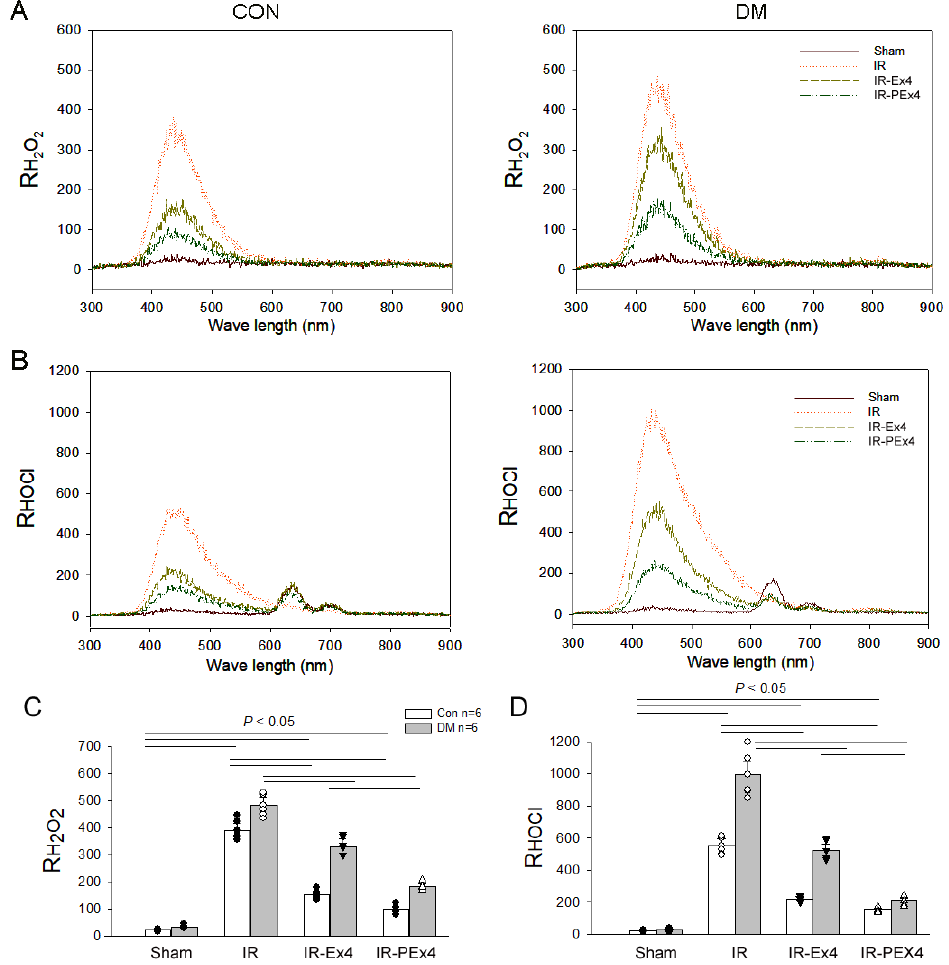
Figure 2. Effect of Ex-4 or PEx-4 treatment on CSF RH 2 O 2 and RHOCl response in the sham or IR rats of control (CON) and diabetes (DM) rats. The typical emission spectra of the chemiluminescence of a test mixture containing H 2 O 2 and luminol for reference H 2 O 2 (RH 2 O 2 ), HOCl, and luminol for reference HOCl (RHOCl) in Sham, IR, Ex-4-treated IR (IR-Ex4) or PEx-4-treated IR rats (IR-PEx4) of CON and DM rats are displayed in ( A , B ). IR increased RH 2 O 2 ( C ) and RHOCl activity ( D ), whereas DM further enhanced these responses. PEx-4 is more efficient in reducing RH 2 O 2 and RHOCl activity in the IR-PEx4 group as compared to Ex-4 in the IR-Ex4 group. The statistical difference is indicated by the horizontal line with p < 0.05 between groups using one-way ANOVA, followed by Bonferroni’s post hoc test. Each symbol represents one sample in different